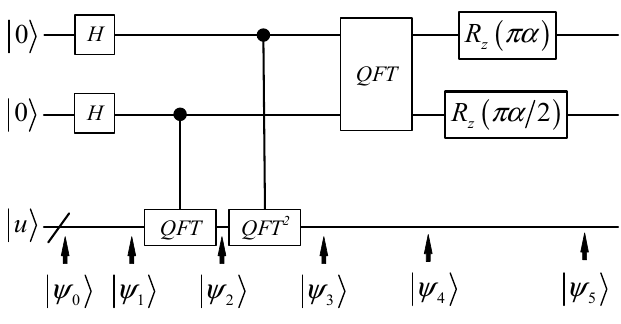
Figure 3. Phase gates are added.